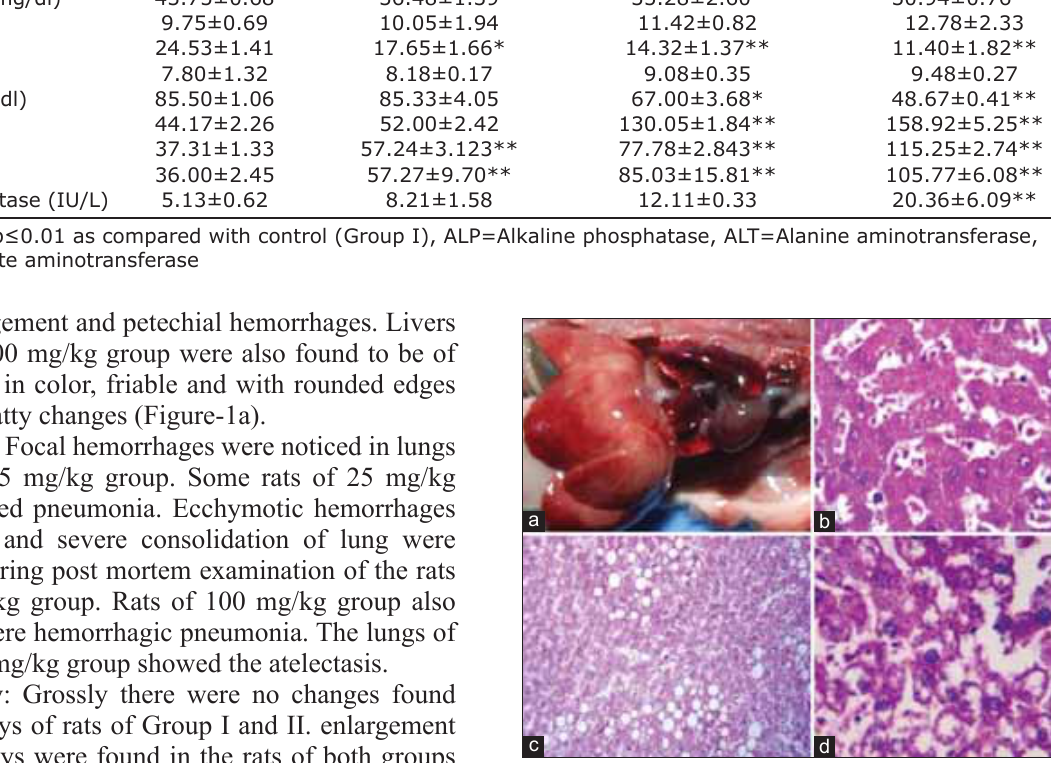
Figure-1: (a) Livers of rats of 200 mg/kg group showing pale color, friable and with round edges, (b) Mild fatty changes and increase eosinophilia in liver of rats of 25 mg/kg group, (c) The liver 100 mg/kg group showed increase granularity of the cytoplasm, severe fatty changes and necrosis, (d) Fatty changes, eosinophilia, focal necrosis leading to lysis of hepatocytes in 200 mg/kg group.